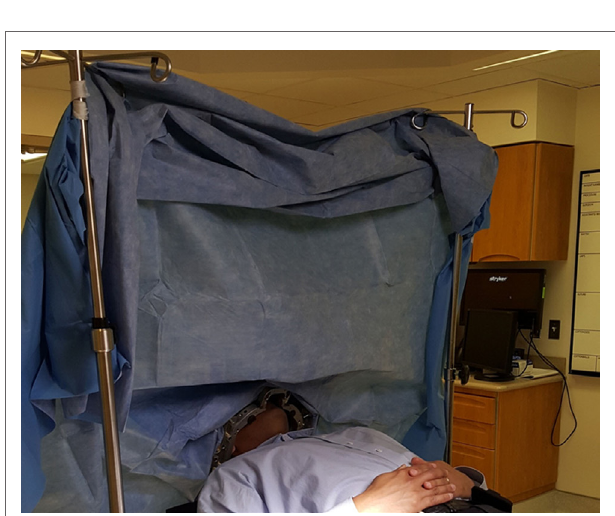
FIGURe 5 | surgical positioning after sterile draping . The sterile field is located behind the drape (not visualized), whereas the interactive patient space is located on the near side of the drape (visualized). This arrangement allows for the team to perform “awake” examination of the arms, legs, and face during deep brain stimulation.